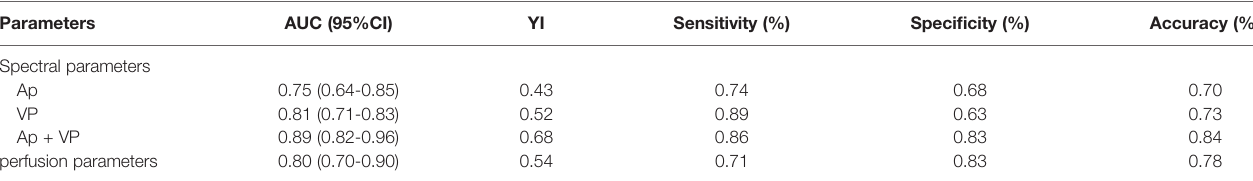
TABLE 4 | ROC curve analysis of spectral and perfusion